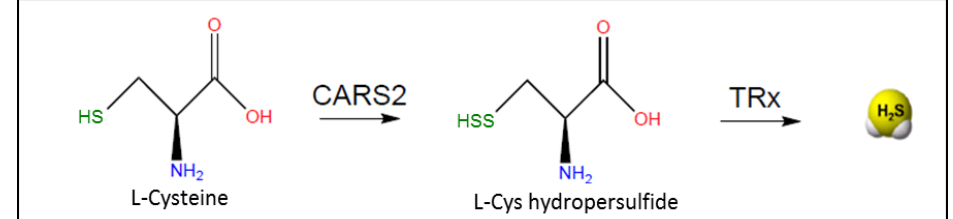
Figure 6. CARS2 reaction contributes to H 2 S formation in cells (CARS2 = cysteinyl tRNA synthetase, TRx = thioredoxin). Inspired by Akaike et al. [112].